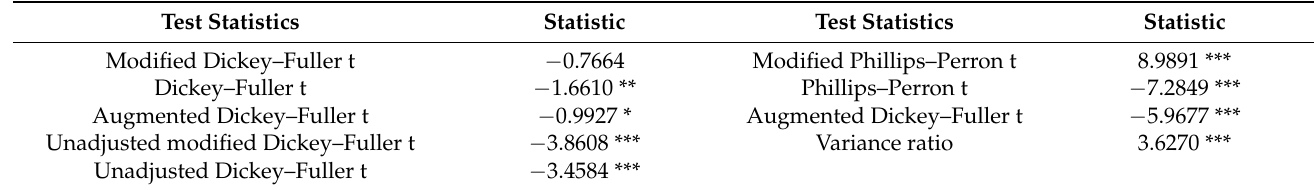
Table 3. Results of the cointegration test of key variables.